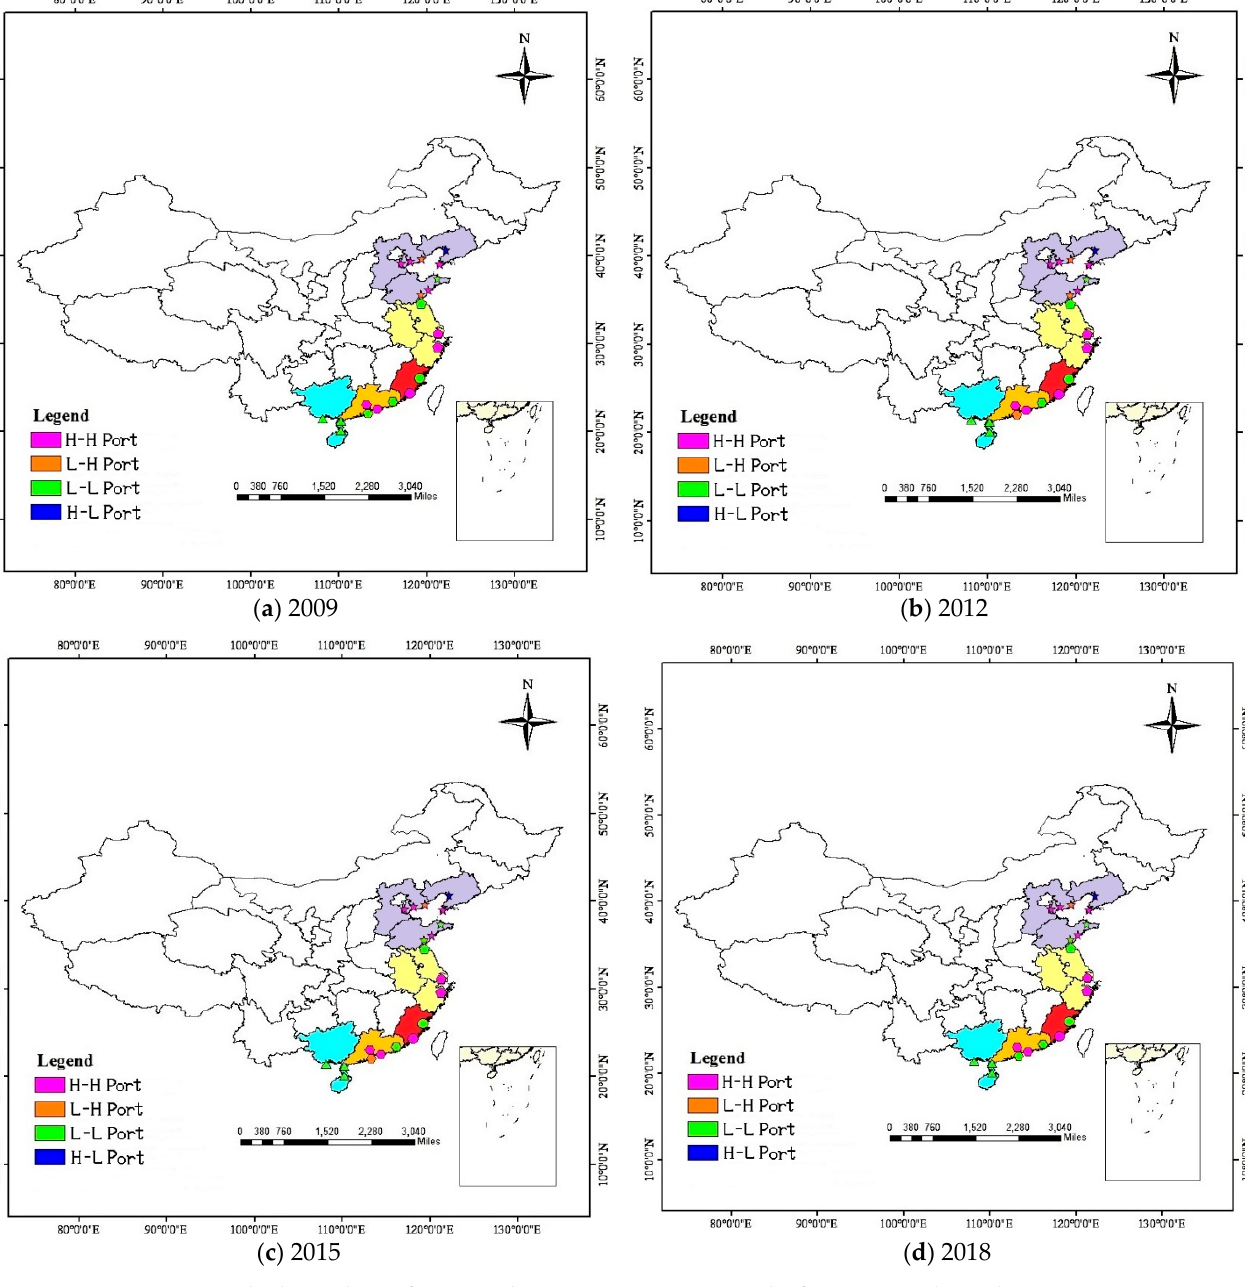
Figure 3. Spatial relationships of twenty Chinese ports, 2009–2018. The figures were drawn by ArcGIS 10.3.